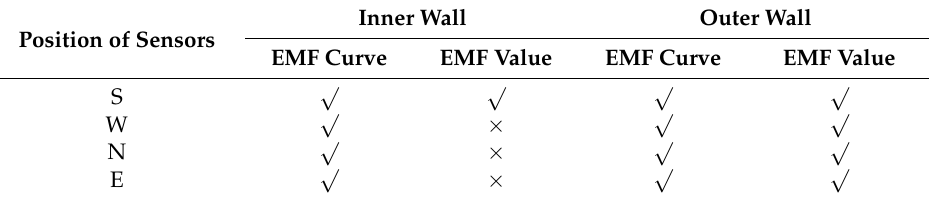
√ : Similar to the Figure 7